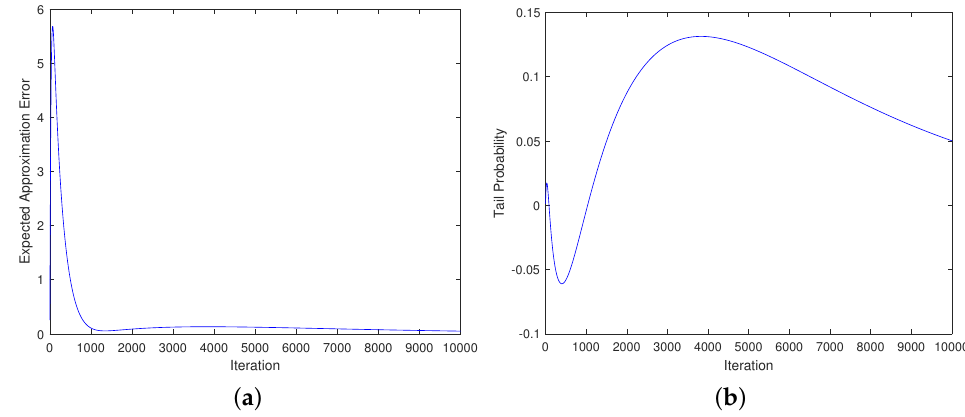
Figure 1. Simulation results on the difference of EAEs and TPs for the counterexample. ( a ) Difference of expected approximation errors (EAEs). ( b ) Difference of tail probabilities